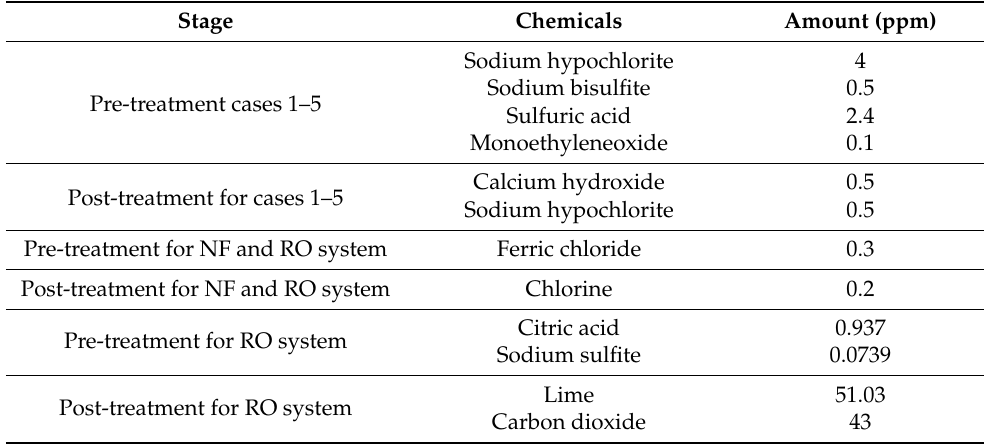
Table 2. Chemical additives in pre-treatment and post-treatment of